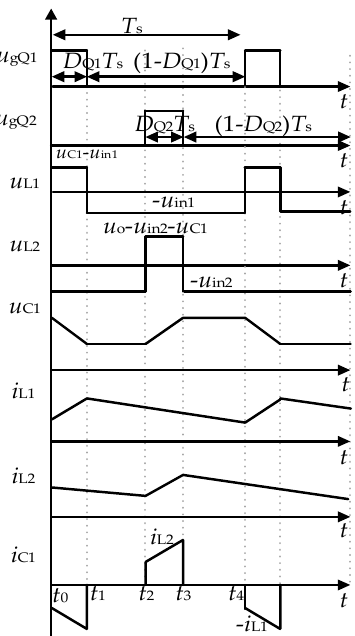
Figure 5. The main waveforms in one switching period T s .